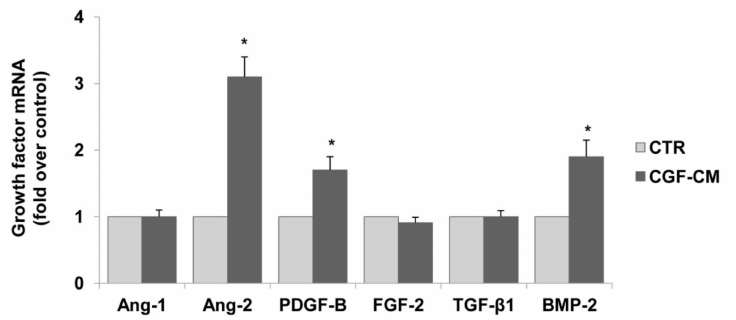
Figure 4. CGFs enhance the expression of pro-angiogenic factors in endothelial cells. HUVECs were incubated with CGF-CM (10%) or culture medium (CTR) for 4 hm and mRNA levels of Ang-1, Ang-2, PDGF-B, FGF-2, TGF- β 1, and BMP-2 were analyzed by qRT-PCR and expressed as fold over unstimulated control (CTR) (mean ± SD). Each experiment consisted of four replicates for each condition. * p < 0.05 vs.